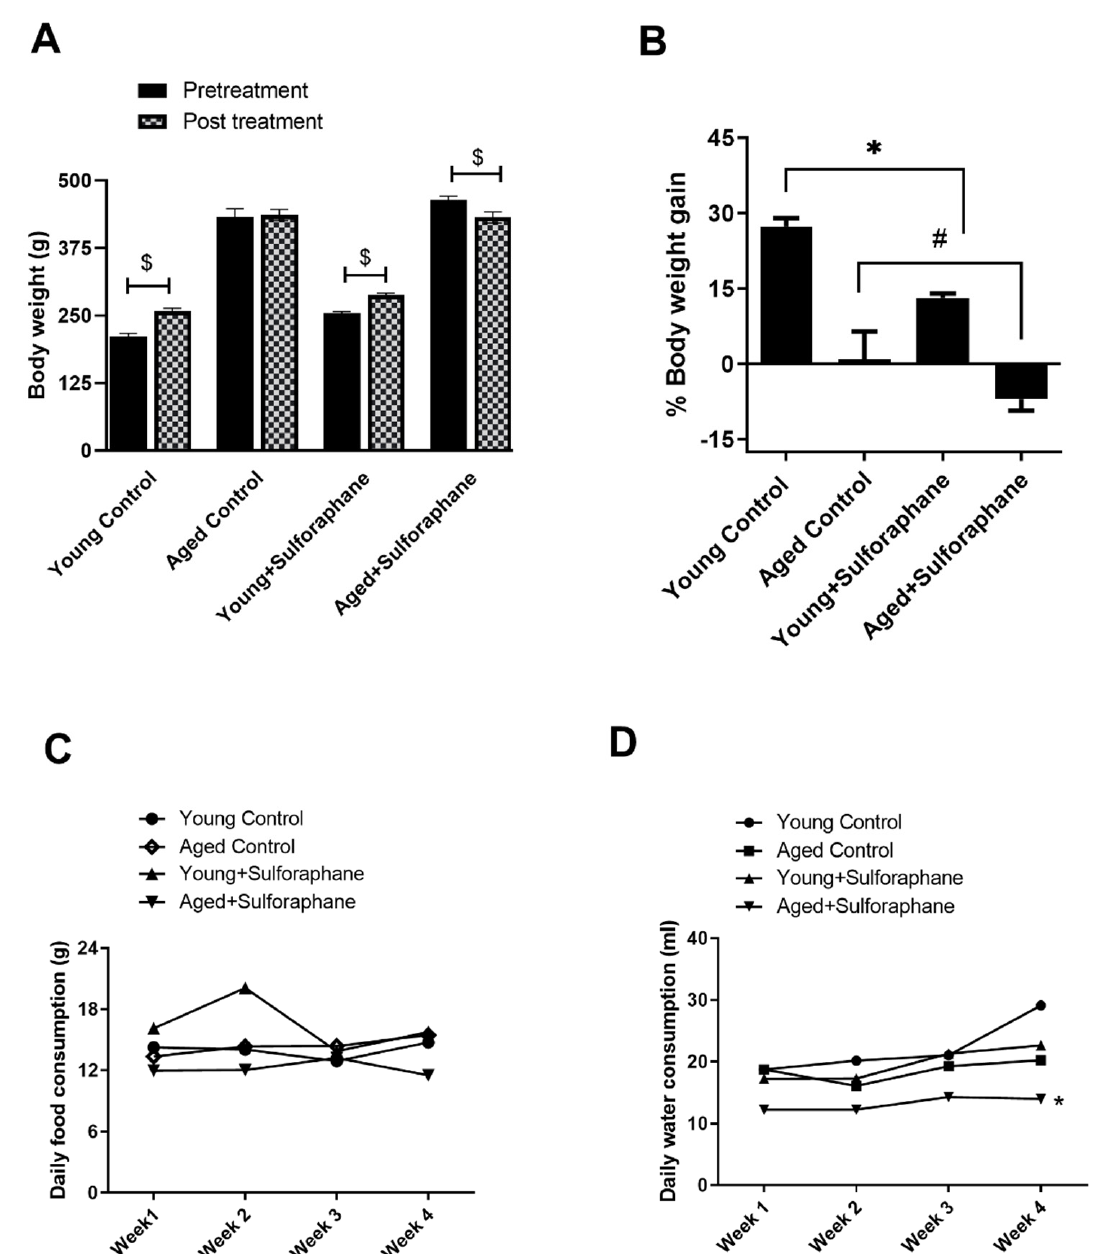
Figure 7. Effect of sulforaphane on body weight gain, food, and water consumption. ( A ) Pre- and post-treatment body weight. ( B ) Percentage body weight gain. ( C , D ) Food and water consumption measured weekly in young control (young F344 rats kept on tap water); aged control (aged F344 rats kept on tap water); young+sulforaphane (sulforaphane, 15 mg/kg body wt/day in drinking water); aged+sulforaphane. Results are presented as mean ± SEM, n = 5 rats. * p < 0.05 significantly different from young control rats; # p < 0.05 significantly different from aged control rats; $ p < 0.05